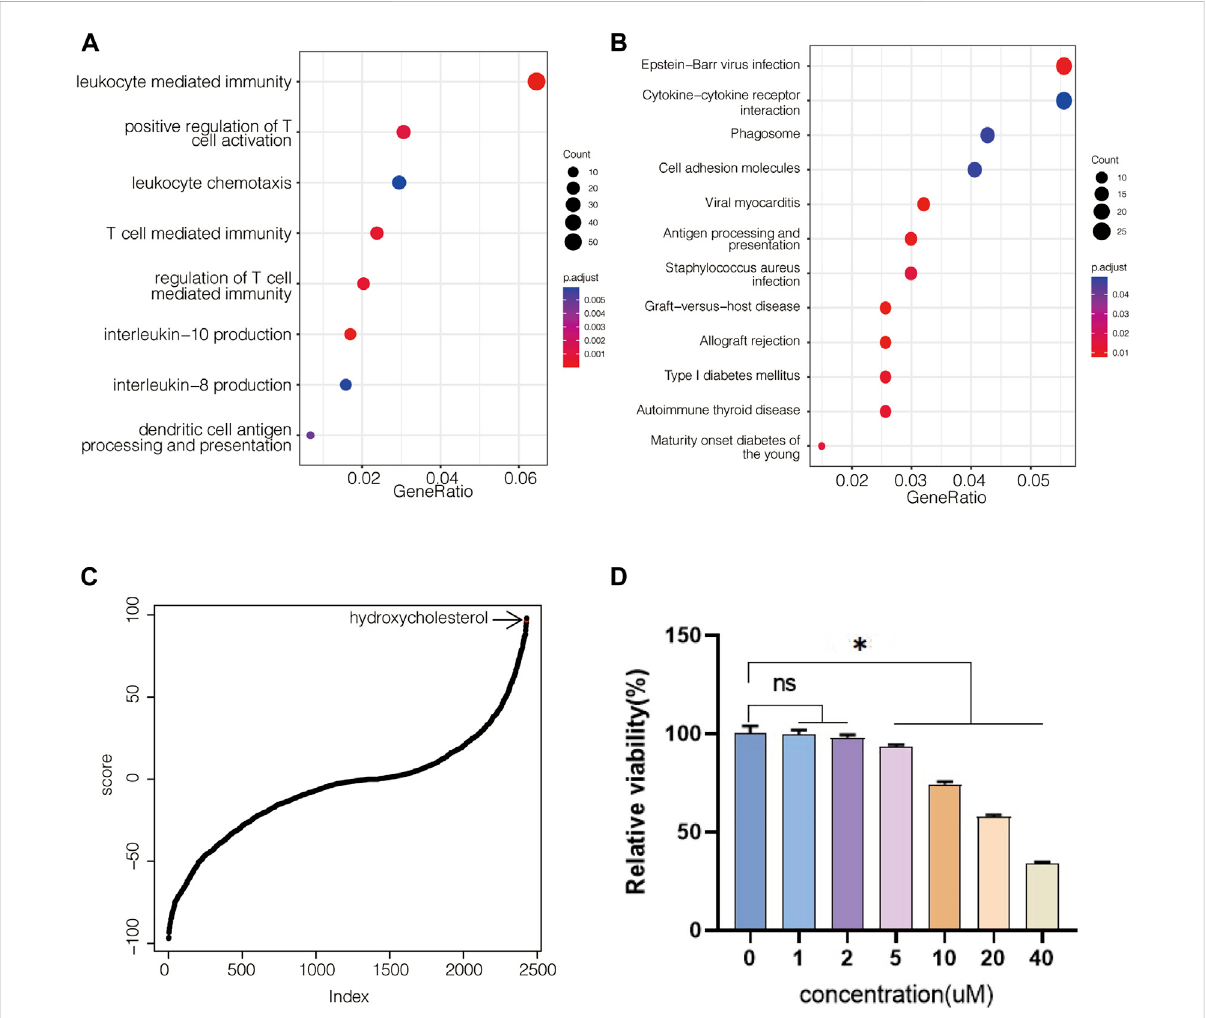
FIGURE 1 Molecular screening based on the icariin-induced gene expression signature. (A) GO-based gene set enrichment analysis of BMSCs administered with icariin at 20 μ M after 24 h; (B) KEGG-based gene set enrichment analysis of BMSCs administered with icariin; (C) hydroxycholesterol is involved in CMap-based molecular screening results from the icariin-induced gene expression signature; (D) cell viability of BMSCs administered with different concentrations of hydroxycholesterol (ns, not signi fi cant; *, p < 0.05).